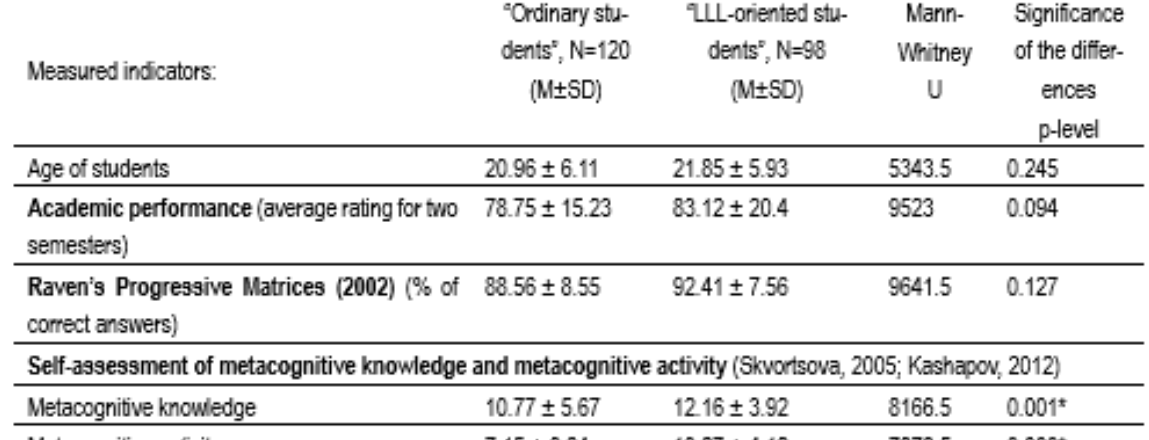
Comparative analysis of samples of students with high and low learning